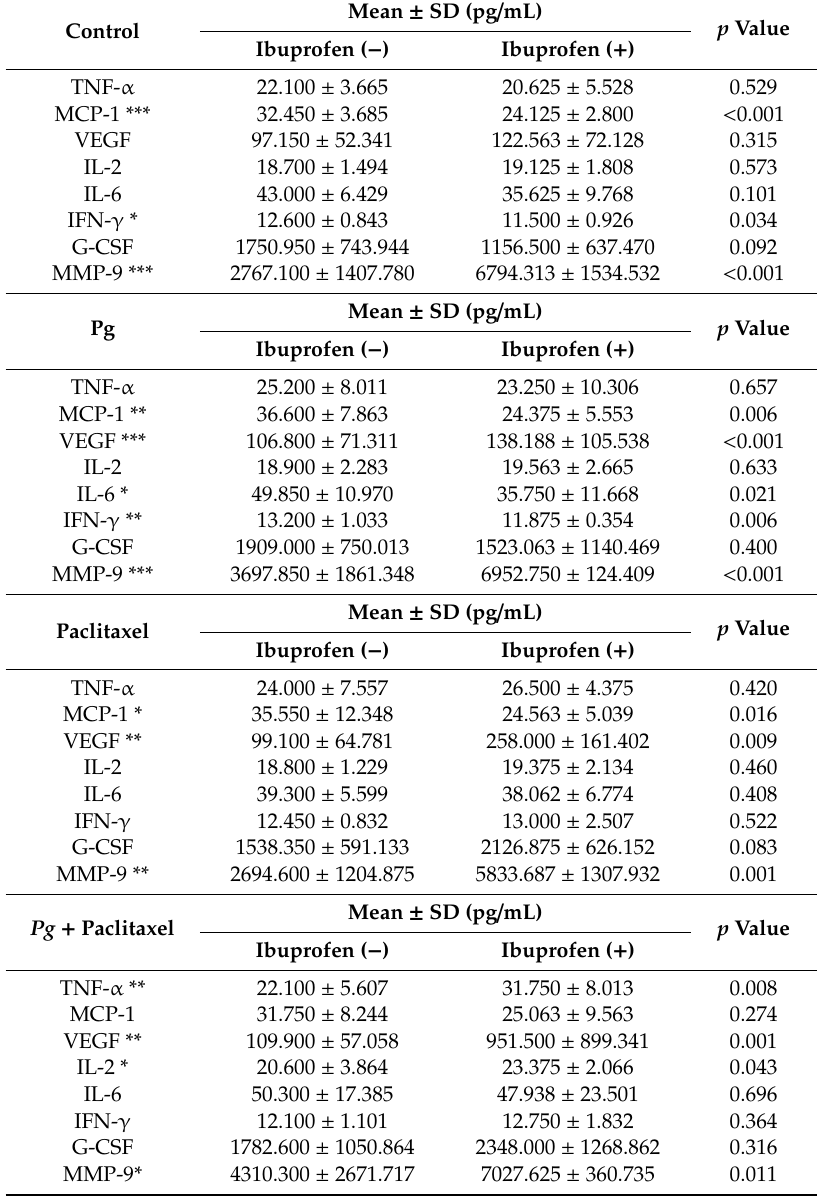
Table 1. Comparison of the cytokine profiles between ibuprofen-treated and untreated mice. Data are presented as the mean ± standard deviation. Significance was assessed using ANOVA. * P < 0.05; ** P < 0.01; *** P <